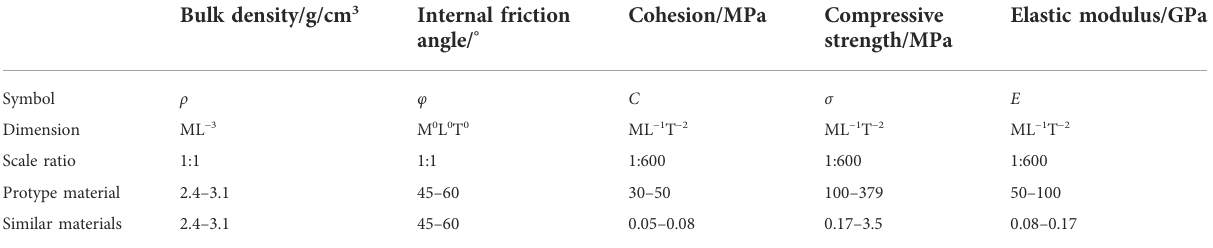
TABLE 2 Parameters used for similarity analysis of the protype and similar